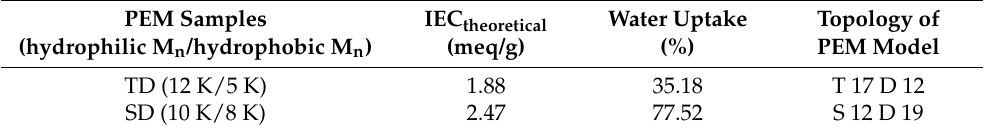
Table 1. Characteristics of sulfonated polyarylene sulfone-multiblock copolymers used as PEM models in the mesoscale simulation of this study.